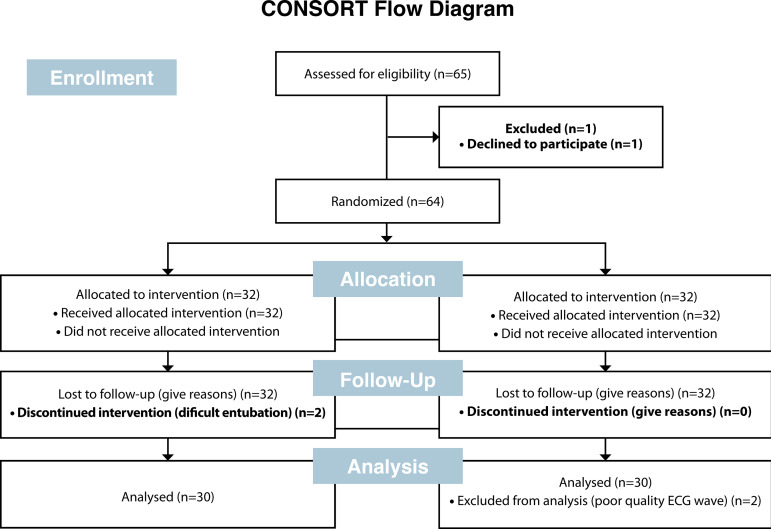
CONSORT flow diagram.CONSORT=Consolidated Standards of Reporting Trials; ECG=electrocardiography